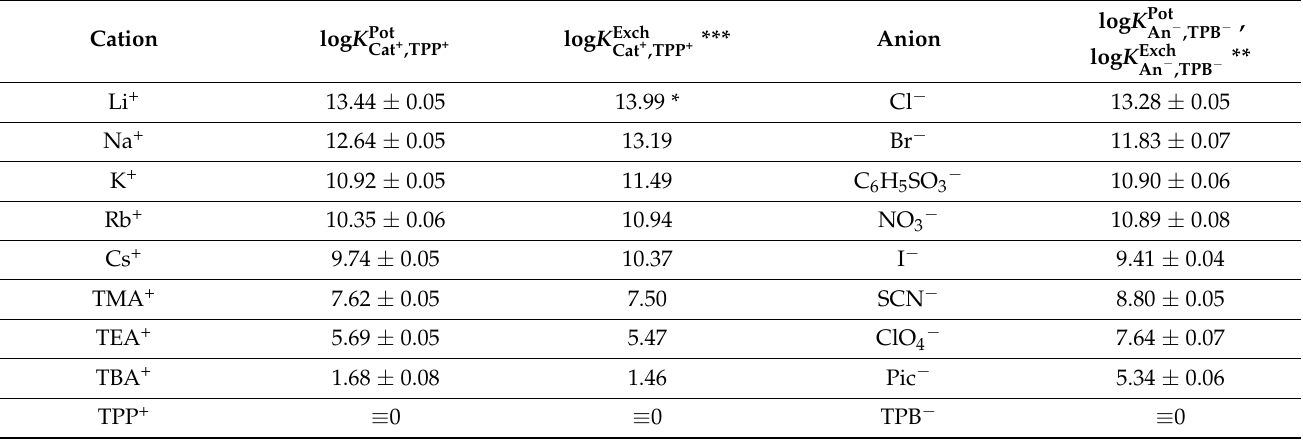
Table 1. Unbiased potentiometric selectivity coefficients for cation- and anion-exchange membranes and corresponding ion-exchange